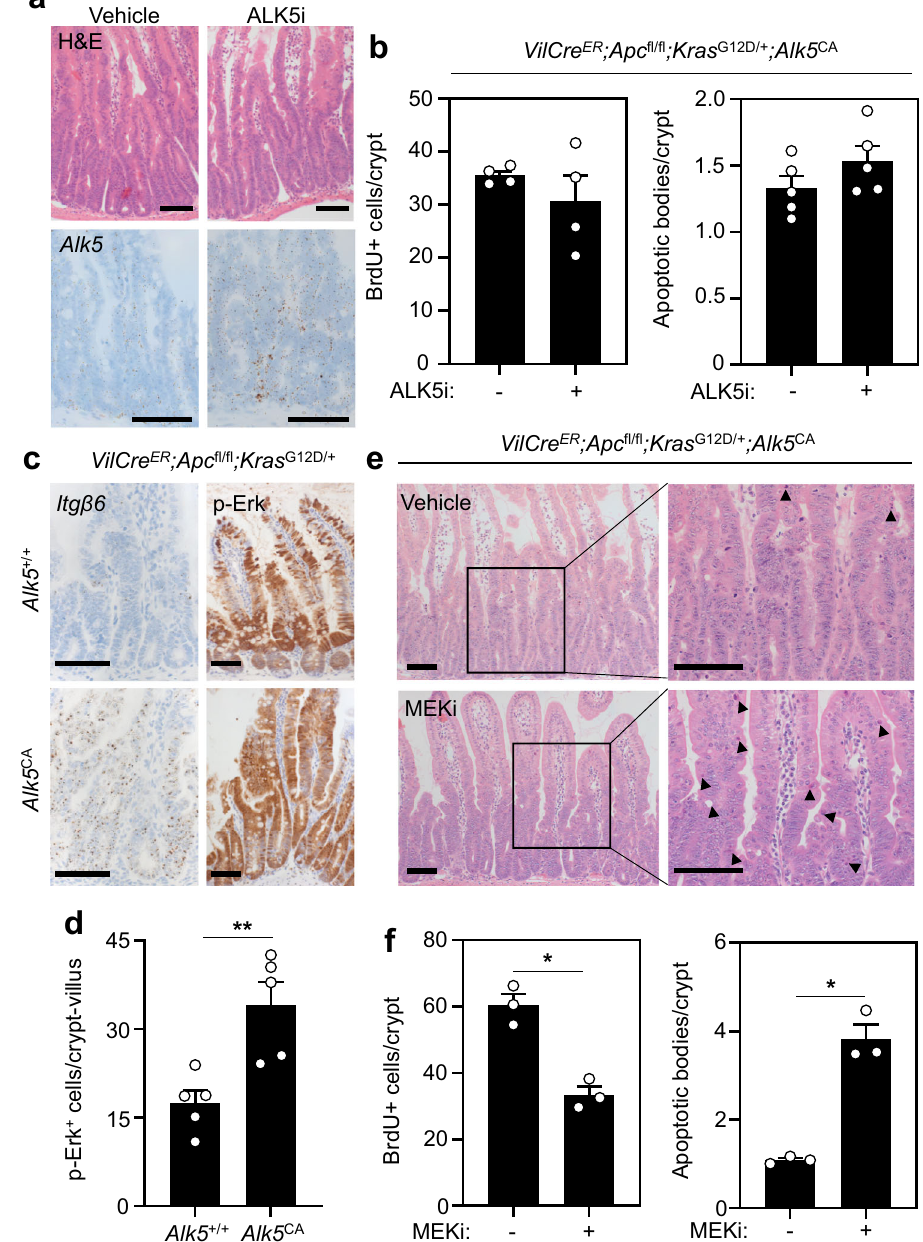
Fig.5|OncogenicKRAS-drivenMAPKsignallingconferstolerancetoepithelial TGF β activation.a RepresentativeH&Eand Alk5 ISHofsmallintestinaltissuefrom VilCre ER ;Apc fl / fl ;Kras G12D/+ ;Alk5 CA mice 3 days post-tamoxifen and daily treatment with vehicle or ALK5-inhibitor (ALK5i). Scale bar, 100 μ m. b Quanti fi cation of BrdU- positive(left)andapoptotic(right)cellsinmicedescribedin a . n =4micepergroup (BrdUscoring); n =5micepergroup(apoptosisscoring).Datawere±s.e.m; P =0.68 (BrdU), P =0.15 (apoptosis); two-tail Mann – Whitney U -test. c Representative Itg β 6 ISHandp-ERKIHConmiceoftheindicatedgenotypes3dayspost-tamoxifen.Scale bars, 100 μ m. d Quanti fi cation of p-ERK-positive cells per crypt-villus unit in